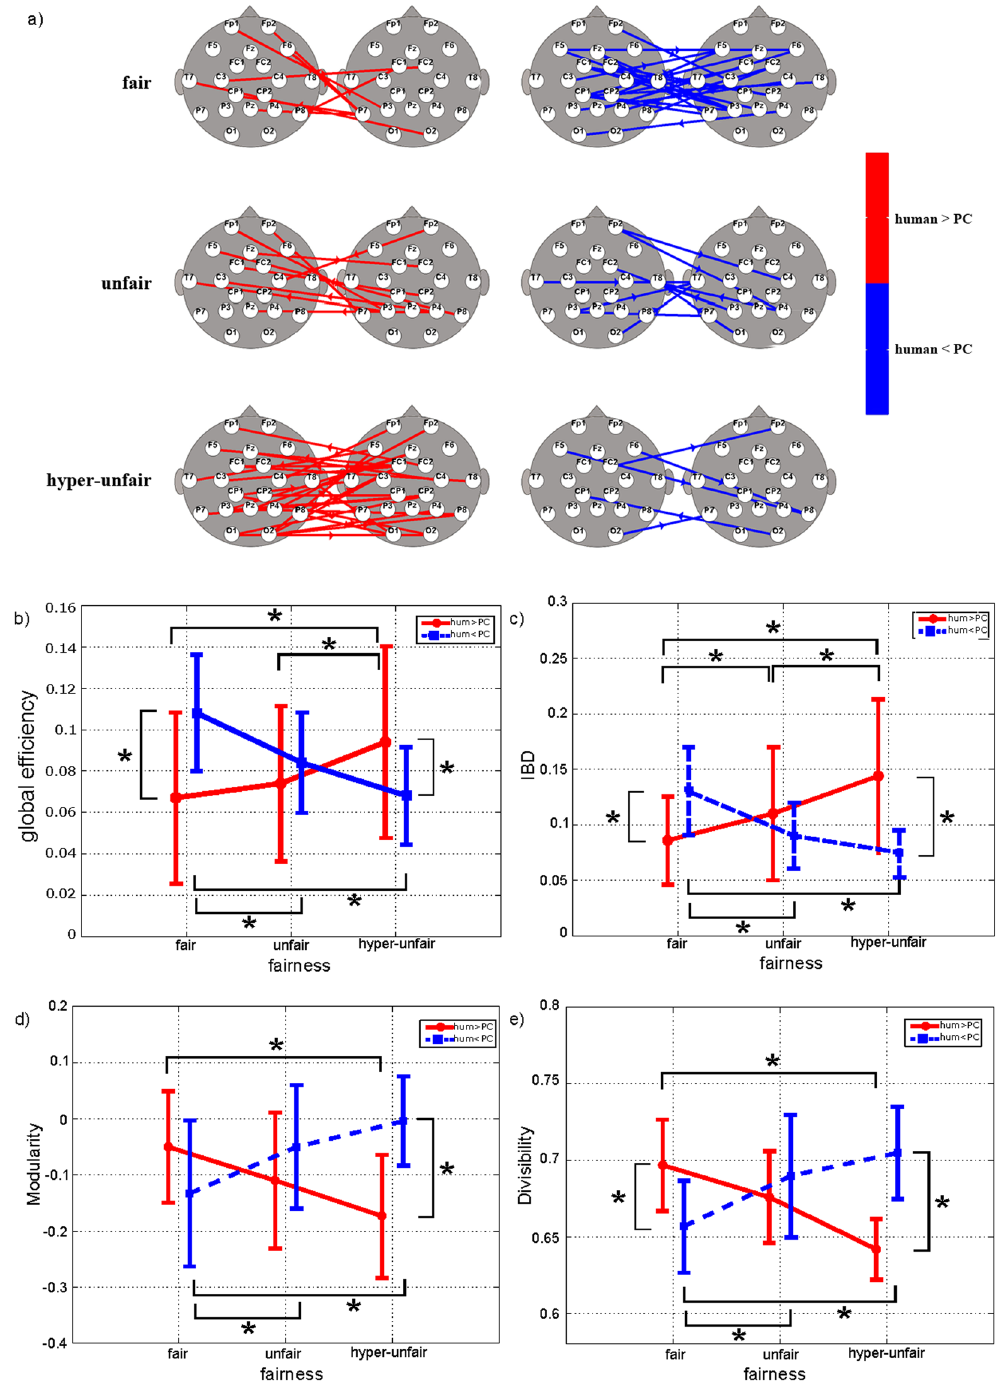
Figure 6. ( a ) Statistical interbrain connectivity patterns in beta band. Statistical interbrain connectivity patterns comparing human vs PC conditions in the beta band (group analysis, paired t-test; p < 0.05 FDR- corrected). The patterns were reconstructed for the three fairness levels separately. Red arrows are for human > PC, and blue arrows are for human < PC. b,c,d,e) Results of two-way ANOVA performed on global efficiency (p = 0.0001, F(2,28) = 19.04) (panel c), interbrain density (p = 0.00001, F(2,28) = 20.83) (IBD - panel b), modularity (p = 0.00021, F(2,28) = 11.66) (panel d), and divisibility (p = 0.00009, F(2,28) = 13.16) (panel e) computed for connectivity networks in beta band. * Indicates statistical differences as confirmed by Neumann- Keuls post hoc test (p <